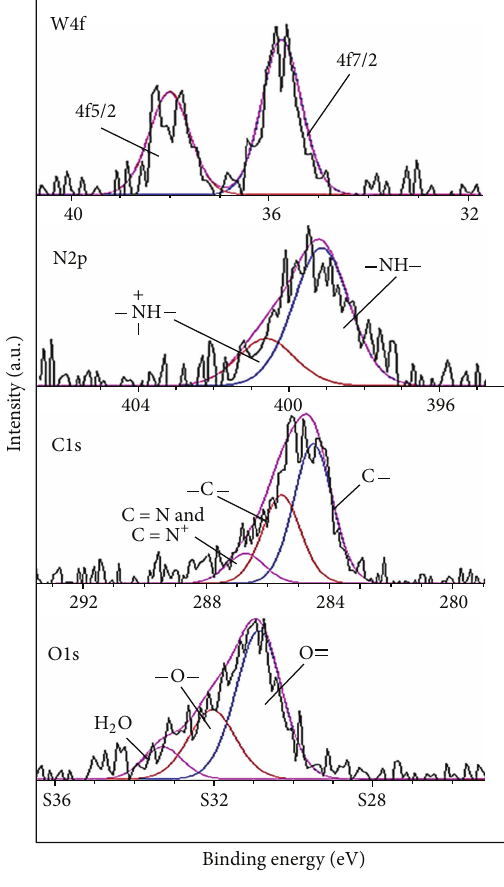
Figure 8: XPS spectra of the O1s, C1s, N2p, and W4f taken on WO 3 - Ppy